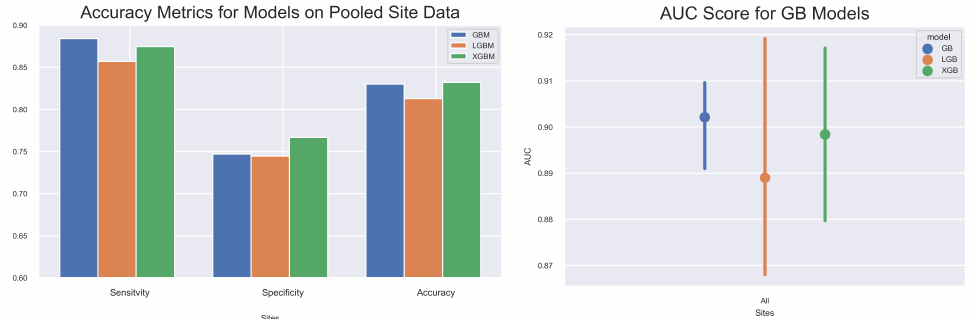
Figure 7. Performance metrics (Sensitivity, Specificity, Accuracy, and AUC scores) for three Gradi- ent Boosting models on pooled data.